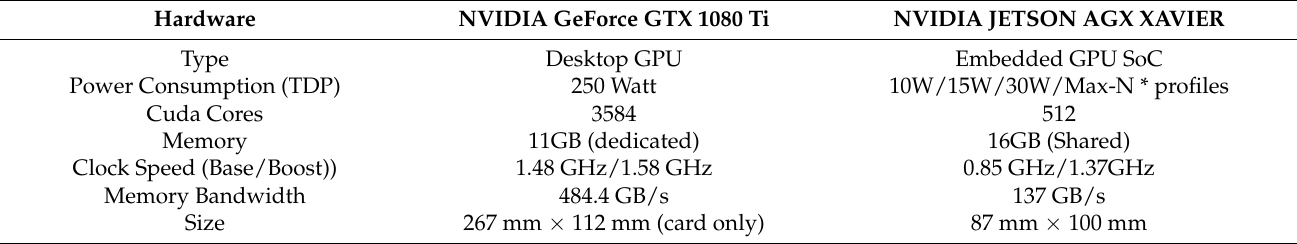
Table 6. Overview of the processing hardware used in this